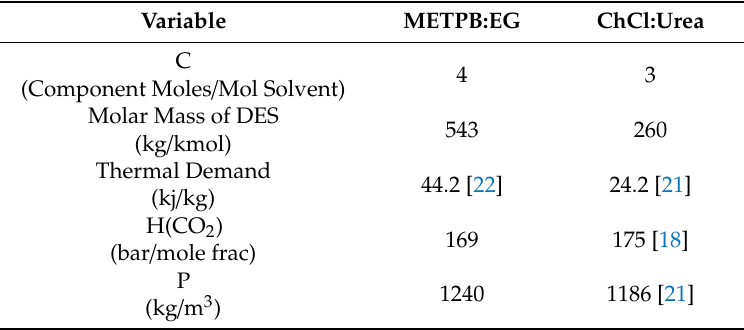
Table 1. DES Solvent Properties from the Literature and